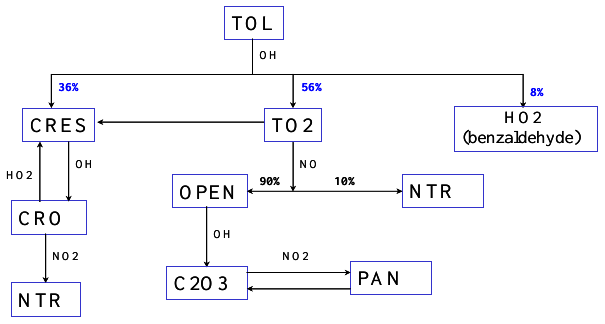
Fig. 1. A simplified schematic diagram of toluene chemistry in CB05-Base